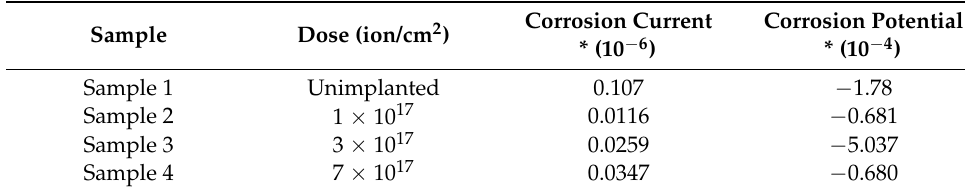
Table 2. The results of sample corrosion tests.